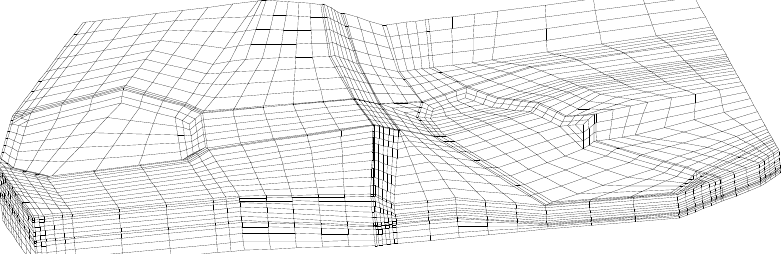
Figure 8. Mesh map of the study area.